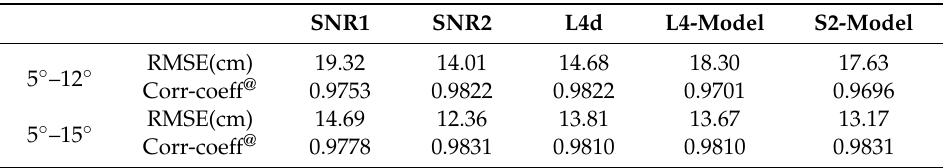
Table 1. Statistical analysis of residual data between sea level changes derived from the GPS multipath effect and tide gauge (TG) observations over the one month period of 1–31 January 2015 with different elevations ranges. SNR1 SNR2 L4d SNR1